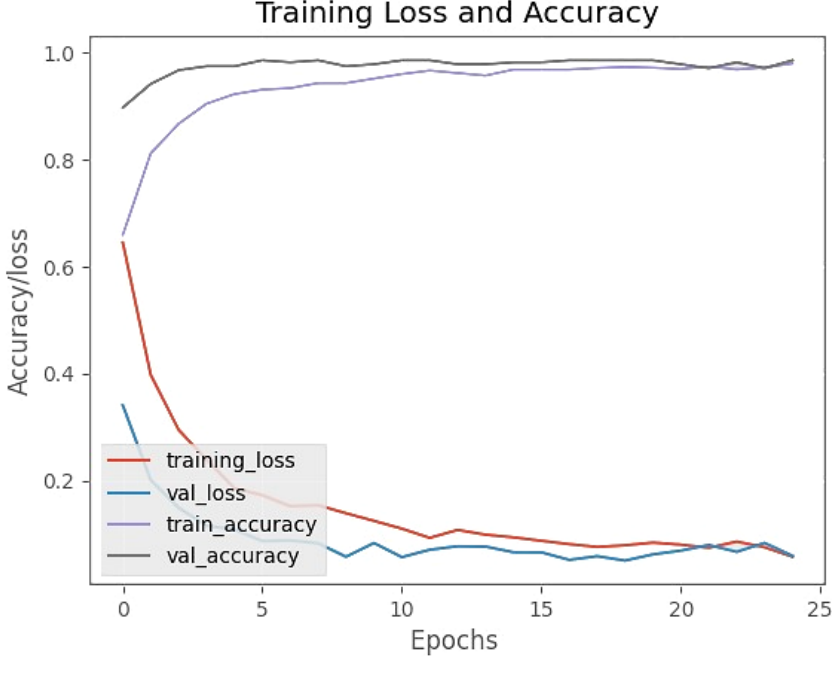
Figure 4. Model Performance